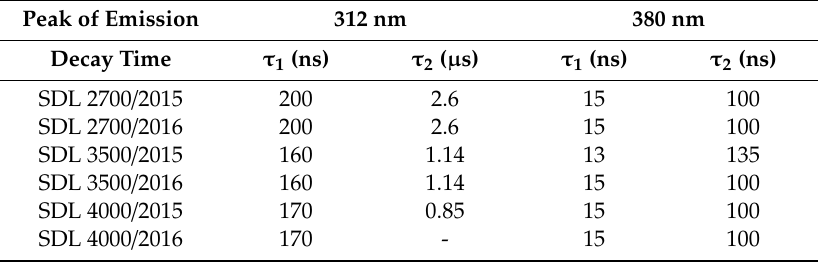
Table 5. Decay time of slow components of CL kinetics in the ultraviolet (UV) spectral region in C-YAG phosphors at 300 K. Peak of Emission 312 nm 380